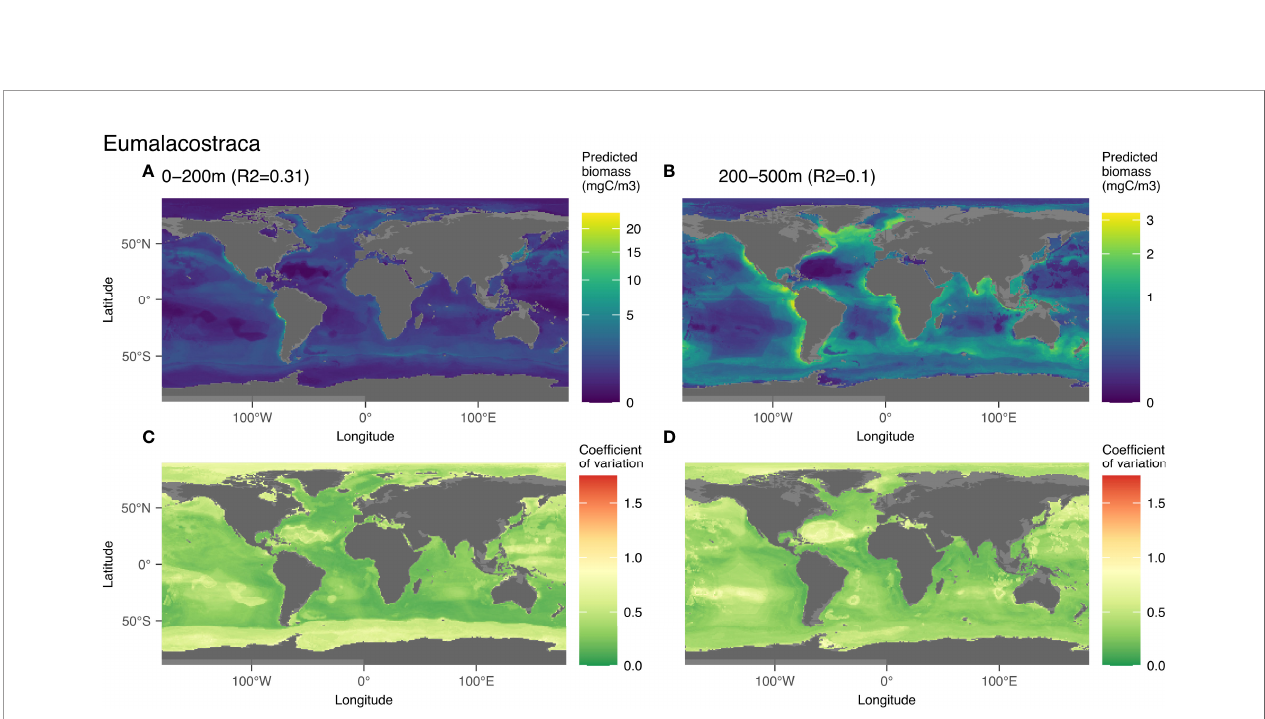
FIGURE 5 | Map of the mean biomass (color scale is log-transformed) of Copepoda as predicted by the model on 0-200 m (A) 200-500 m data (B) as well as the coef fi cient of variation for the 0-200 m model (C) and 200-500 m one (D) . The color scale for the coef fi cient of variation has the same range for Figures 5 – 9